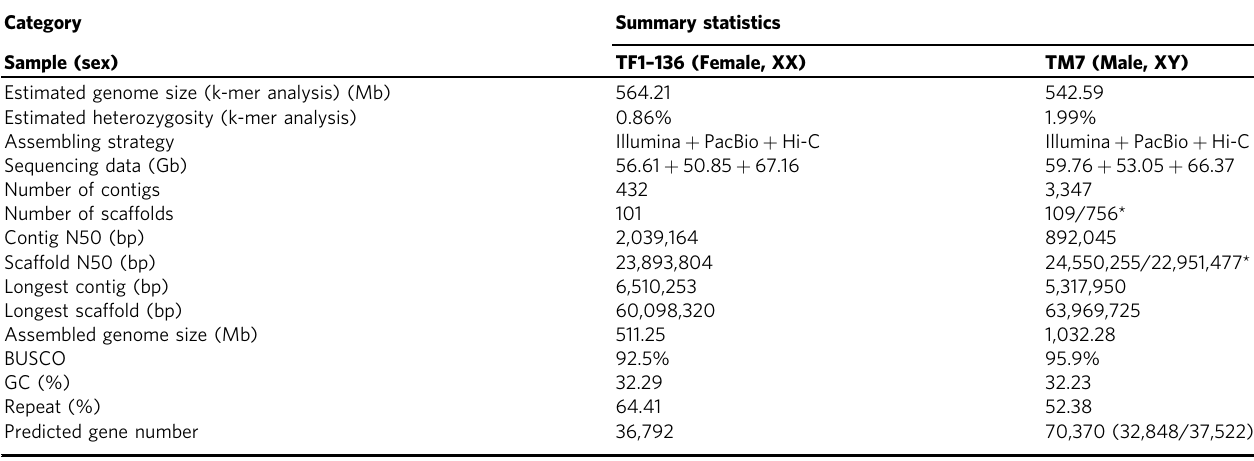
Table 1 Characteristics of the female and male genomes of P. euphratica